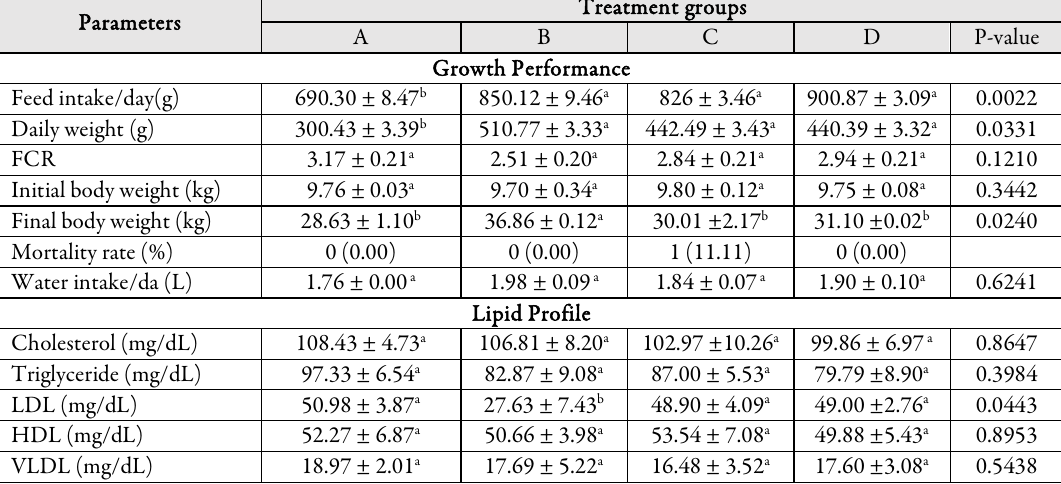
Table 2. Growth performance and lipid profile of weanling pigs fed with graded levels of gut balance booster supplemented